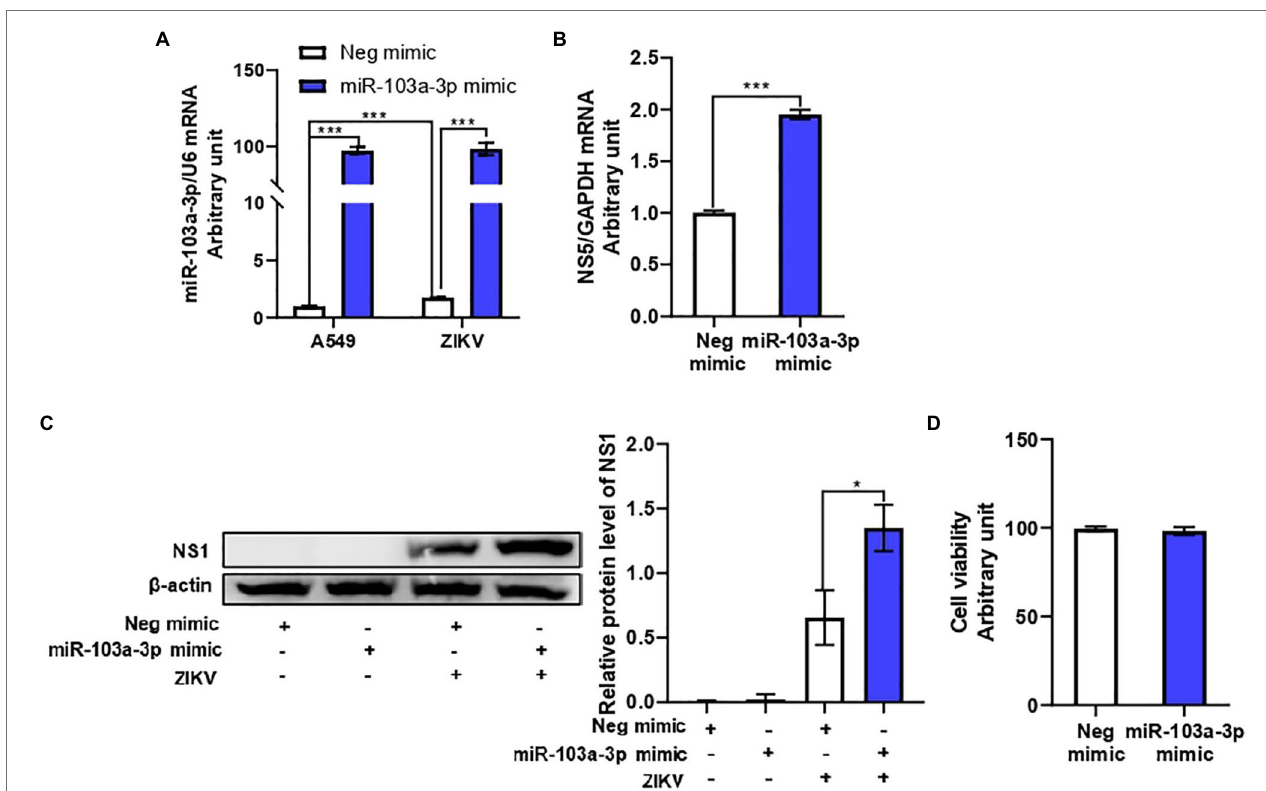
FIGURE 2 | miR-103a-3p stimulates ZIKV replication in A549 cells. A549 cells were transfected with miR-103a-3p mimic or corresponding negative control at a final concentration of 10 nM and infected with ZIKV at a MOI of 0.5. Total RNA and protein of cells were harvested at 48 h post infection for qRT-PCR and Western blot analysis, respectively. (A) Level of miR-103a-3p over-expression. (B) MiR-103a-3p over-expression promotes ZIKV NS5 RNA expression. (C) MiR-103a-3p over-expression enhances ZIKV NS1 protein level. (D) miR-103a-3p mimic or negative control transfection does not affect cell viability. Data are presented as mean ± SD. Error bars indicate SD ( n ≥ 3). * p < 0.05 and *** p <